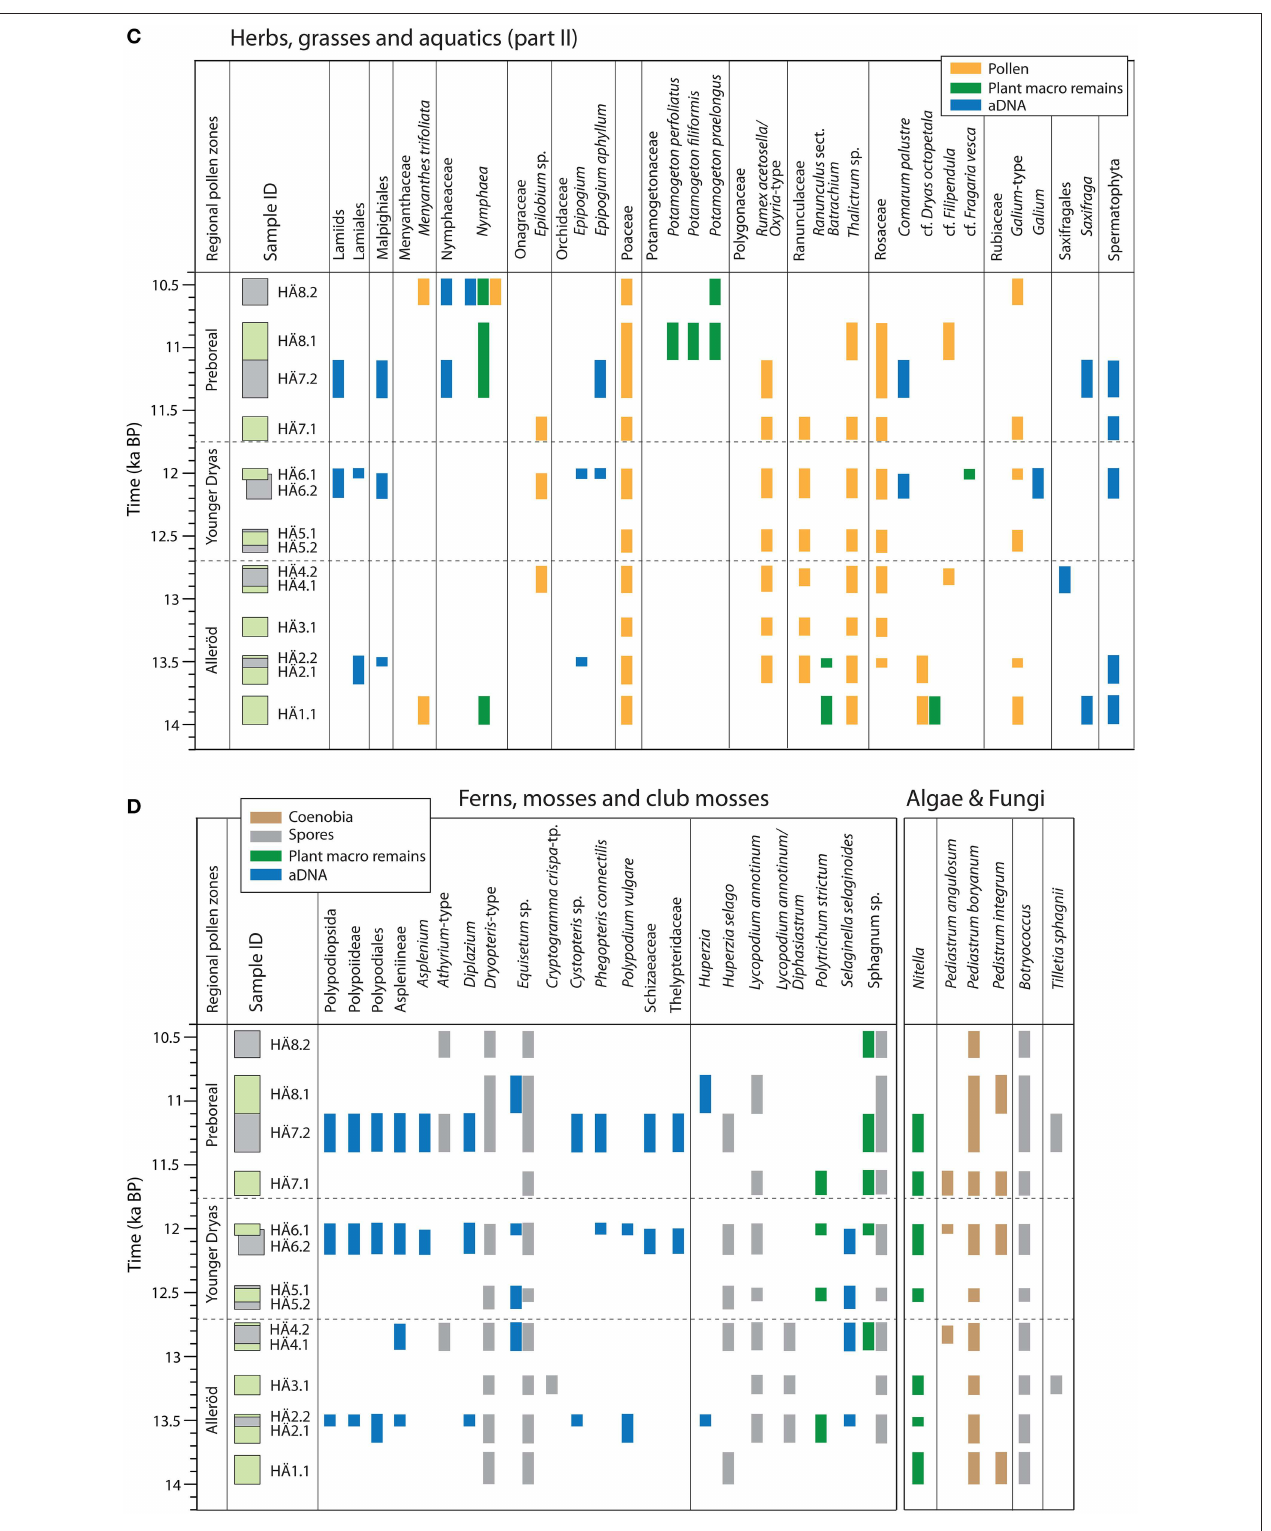
FIGURE 3 | Comparison between the results of micro- and macrofossil analyses and eDNA in Hässeldala Port’s sediments shown according to age and in relation to the regional pollen zones. Samples from core #7.4 are shown in green and samples from core #8 in gray. (A) Trees, shrubs, and dwarf shrubs. (B,C) Herbs, grasses, and aquatic plants. (D) Ferns, mosses, algae, and fungi.